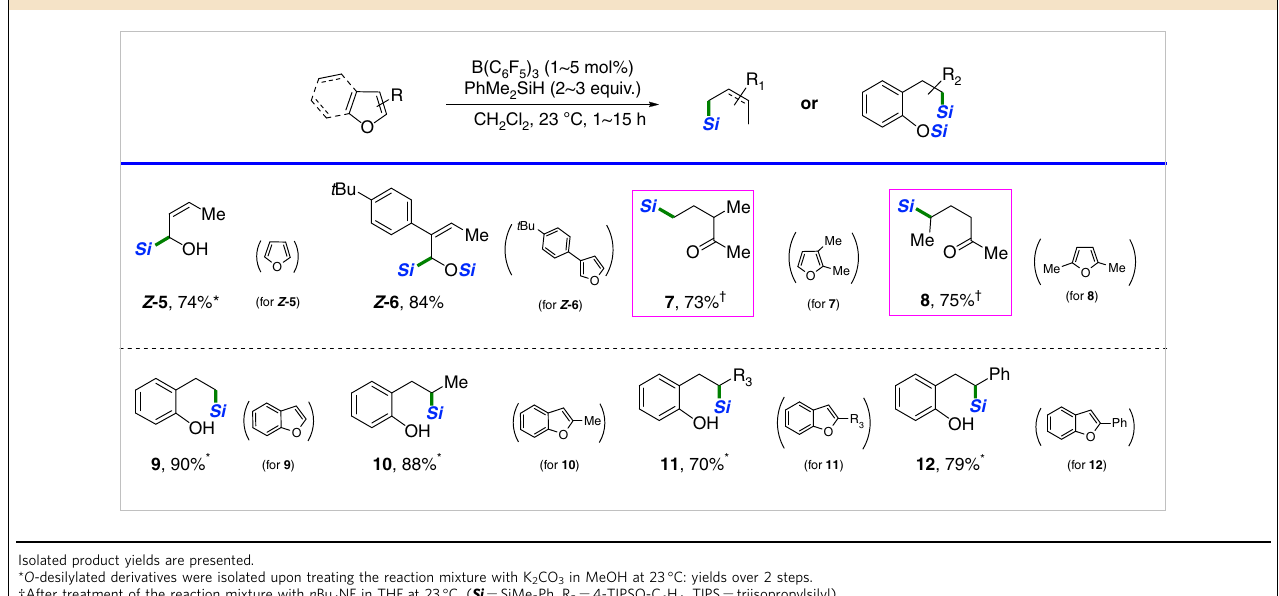
Table 2 | B(C 6 F 5 ) 3 -catalysed silylative ring-opening of derivatives of furan and benzofuran.